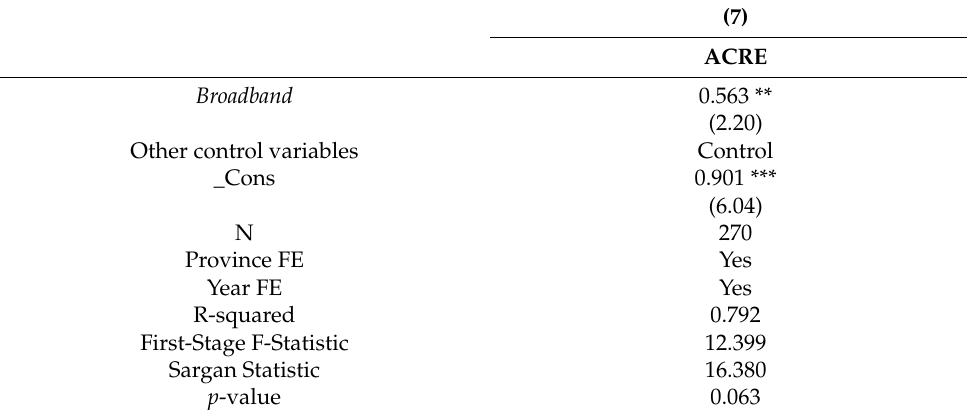
Table 7. Endogenous treatment: Lewbel